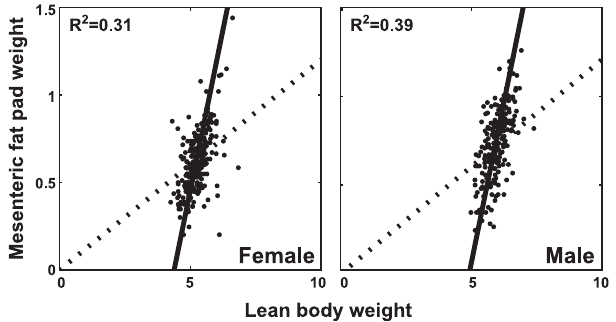
Figure 2. Relationship of Mesenteric Fat Pad Weight to Lean Body Weight for Female and Male Animals Both phenotypes are square root transformed. The dotted line indicates the ratio standard of constant adiposity index. The solid line is the regression of mesenteric fat pad weight on lean body weight. DOI: